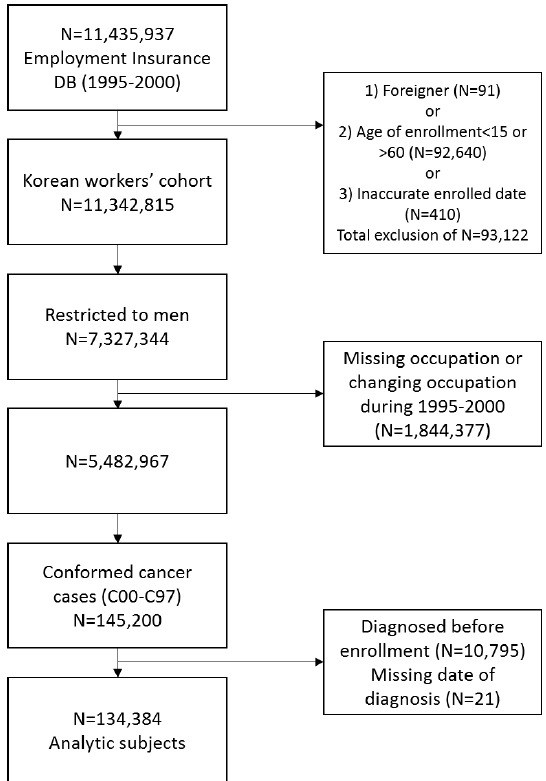
Figure 1. Selection of study Figure 1 Selection of study population.